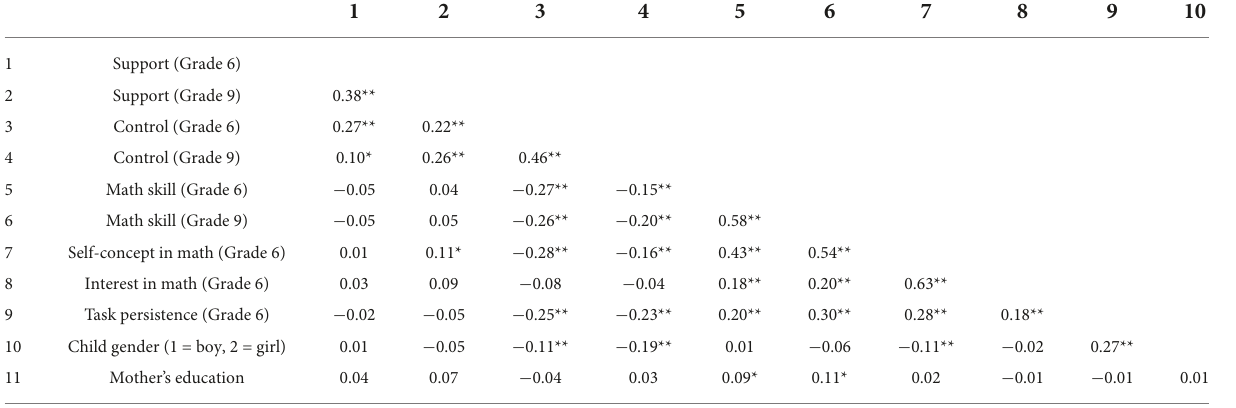
TABLE B2 Correlations between study